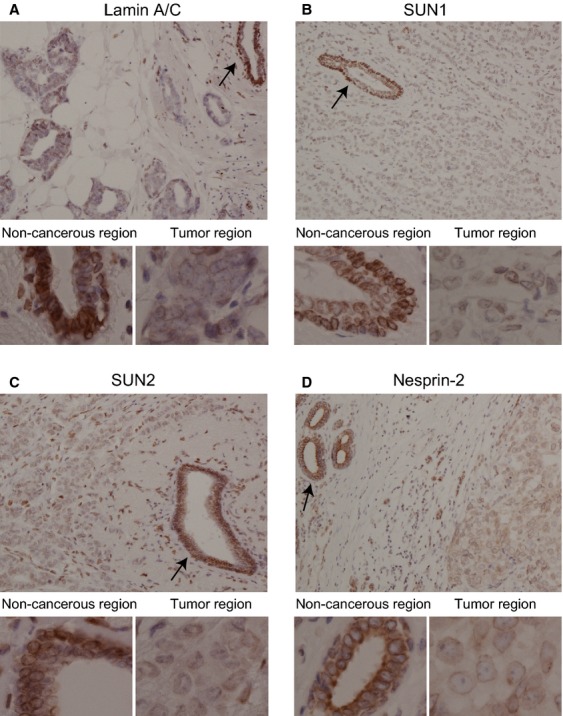
Loss of lamin A/C, SUN1, SUN2, and nesprin-2 staining in the cancerous regions of breast cancer tissue. (A–D) Noncancerous and cancerous regions of breast cancer tissue were stained with anti-lamin A/C (A), anti-SUN1 (B), anti-SUN2 (C), and anti-nesprin-2 (D) pAbs; representative staining patterns are shown. The upper panels were obtained at lower magnification than the lower panels. Most myoepithelial cells stained more strongly for anti-SUN1 pAbs in cancer-associated noncancerous regions than in most mammary epithelial cells, but not in all cases (see Fig.2).